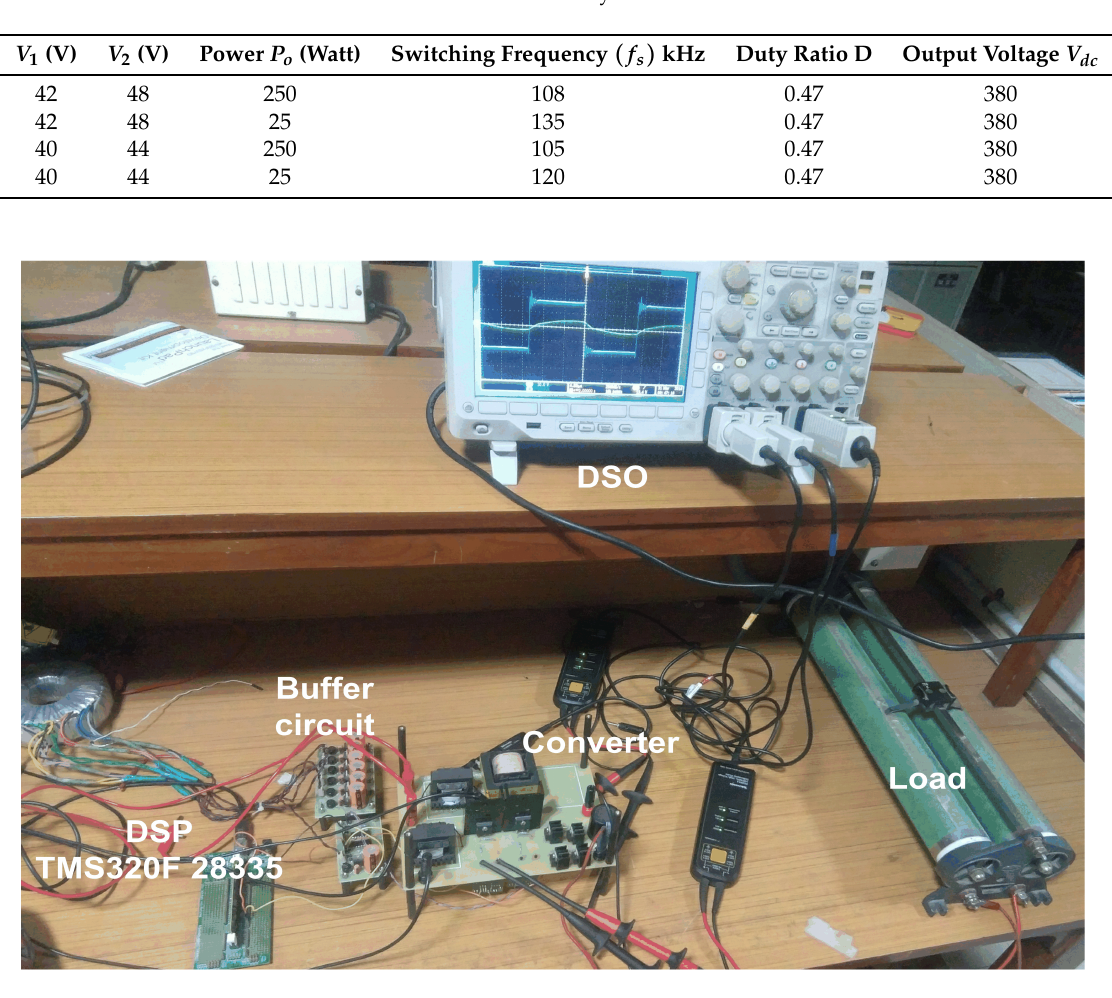
Figure 7. Experimental